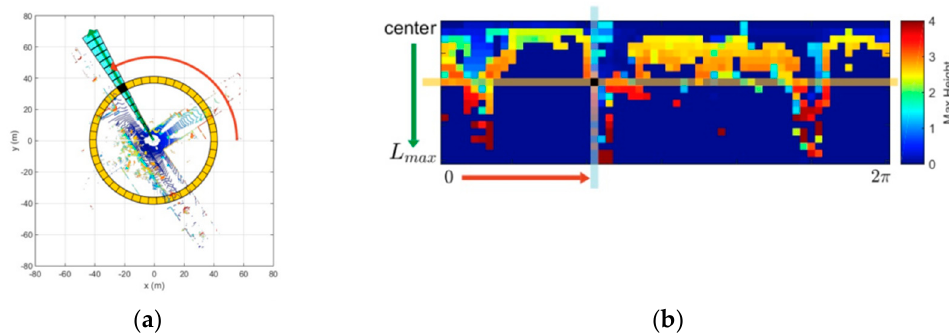
Figure 2. Construction diagram of scan context global descriptor. ( a ) Top view of one frame of point cloud; ( b ) Rectangular image expanded from the top view.